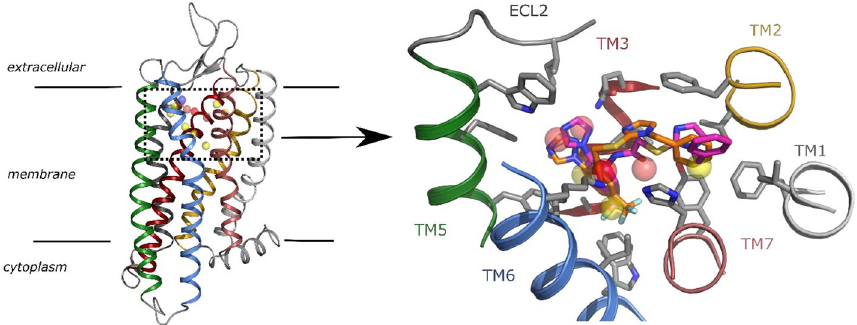
Figure 1. ASTA Receptor model and pharmacophore. (Left) Cartoon representation of the homology model of the ASTA-R with transmembrane helices displayed in different colors. The dotted rectangle indicates the localization of the typical orthosteric binding pocket in class A GPCRs (zoomed in the right panel). Spheres represent the 13 pharmacophoric features defined for the virtual screening (yellow: hydrophobic, red: hydrogen bond acceptor, purple: negative charge). (Right) Zoom of the orthosteric pocket of ASTA displaying the best two docking poses of compound A8 (colored by atom type with carbons in orange or magenta). Spheres represent the 7 pharmacophoric features matched by compound A8 in the virtual screening. Helices are shown as cartoon and residue side-chains around A8 as sticks (colored by atom type with carbons in grey). ECL: extracellular loop; TM: transmembrane